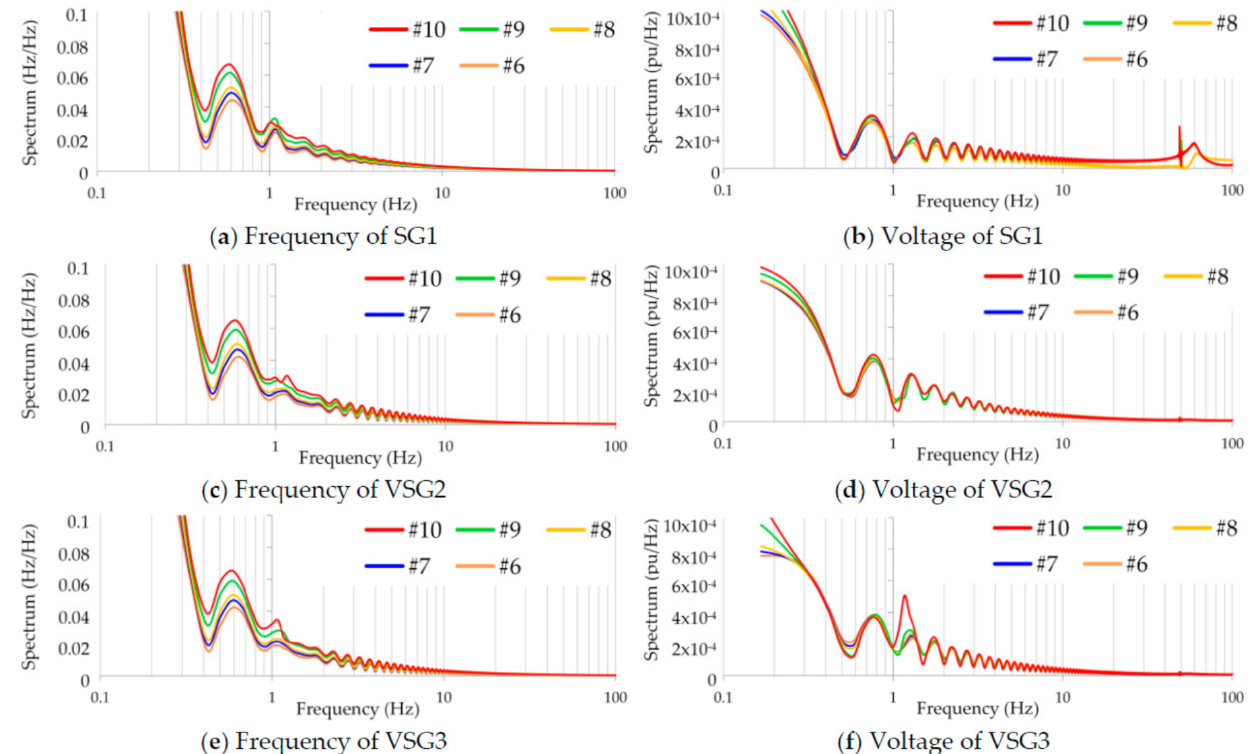
Figure 9. DFT analysis of the system frequency/voltage for tests 6–10 in Table 1.